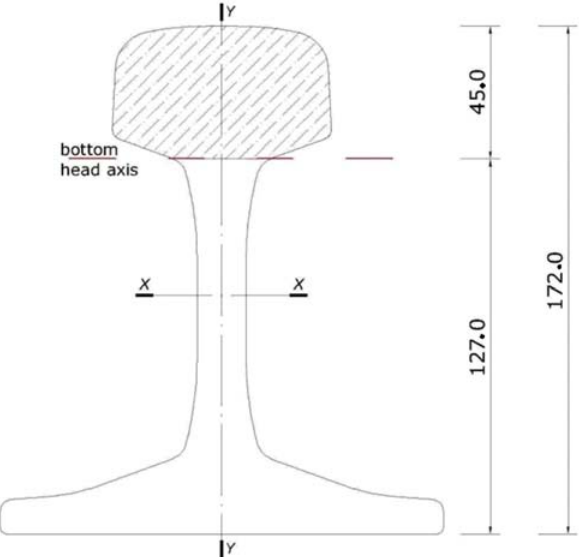
Figure 1: Rail cross section with the rail head